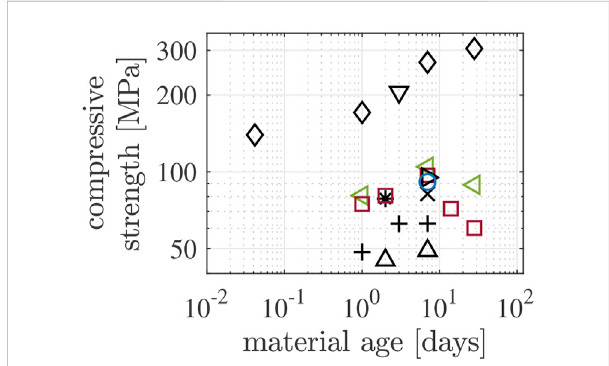
FIGURE 1 Compressive strength values of Biodentine either cured in distilled water or at/close to 100% relative humidity, see Table 1; different markers correspond to different authors: △ Kayahan et al. (2013), ⊳ Elnaghy (2014), + Jang et al. (2014), > Butt et al. (2014), * Dawood et al. (2015), 9 Moreno-Vargas et al. (2017), ▽ Subramanyam and Vasantharajan (2017), ◦ Keskin et al. (2019), □ Atmeh (2020); different colors correspond to different inner mold dimensions: black to length = 6 mm and diameter = 4 mm, red to length = 10 mm and diameter = 5 mm, green to length = 6 mm and diameter = 3 mm, blue to length = 5 mm and diameter = 4